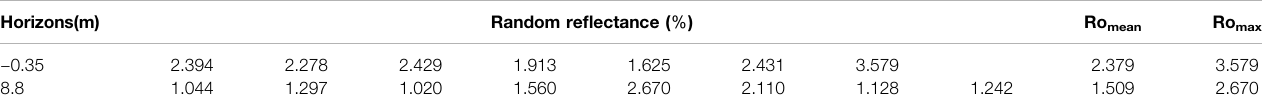
TABLE 2 | Re fl ectance data of the charcoals from the horizons of − 0.35 m and 8.8 m of the Lengqinggou section in Guizhou Province, Southwest China. Horizons(m) Random re fl ectance ( ％ ) Ro mean Ro